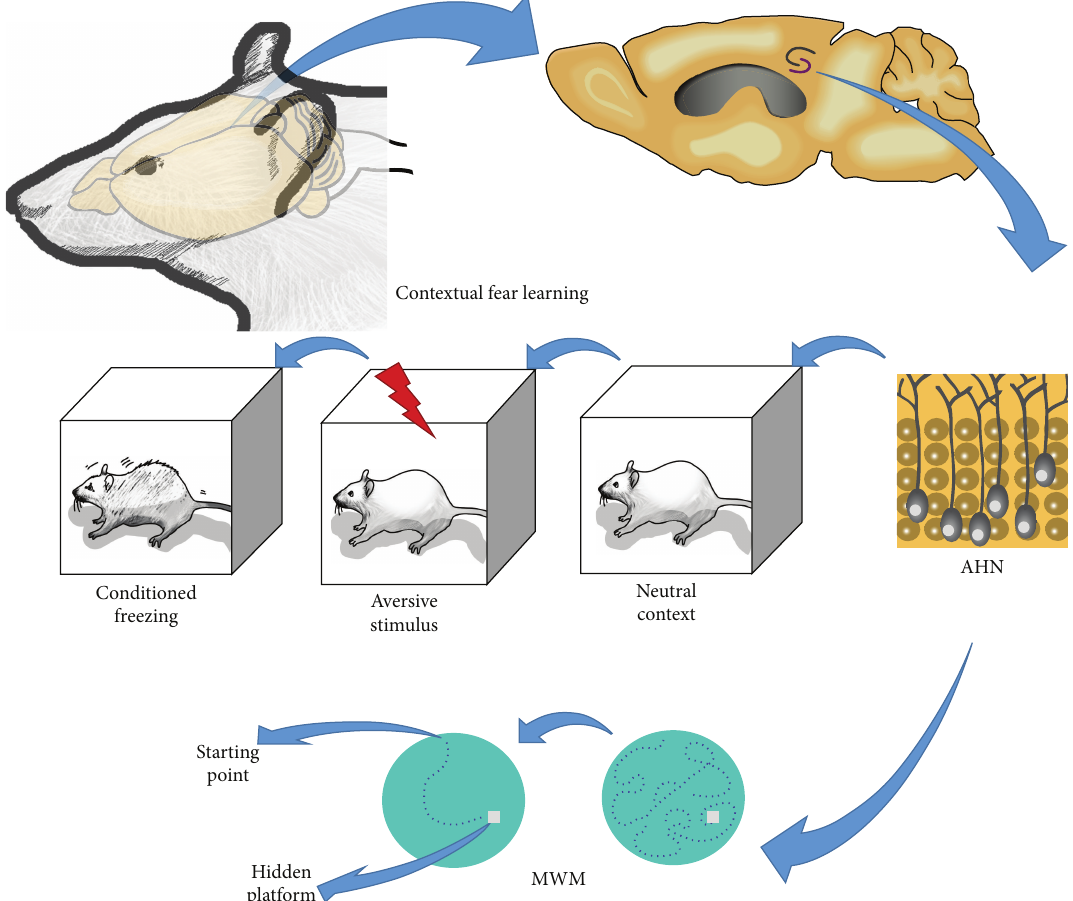
Figure 1: AHN is important for cognitive and emotional learning. The newly born neurons continuously generated in the postnatal hippocampus are believed to regulate cognitive and emotional tasks, as occurs in the contextual fear learning paradigm and the spatial learningassessedintheMWM.Incontextualfearlearning,thehippocampusisthoughttobeessentialfortheassociationbetweenapreviously neutral context and an aversive stimulus (in this case, a mild footshock) leading to a fear response (conditioned freezing) when the individual is reexposed to the context where the fear learning occurred. In the case of spatial learning, as assessed by the MWM, hippocampal cells are believed to play an important role in the cued spatial navigation strategies that make it possible for the rodent to more quickly find the hidden platform across the test trials. AHN = adult hippocampal neurogenesis; MWM = Morris water